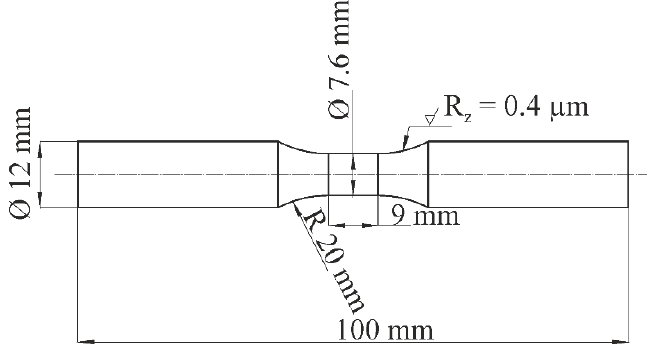
Figure 1. Geometry of the fatigue